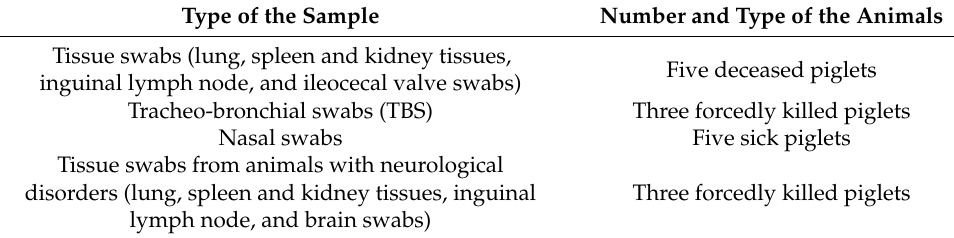
Table 1. Characteristics of the study samples for nanopore sequencing analysis. Type of the